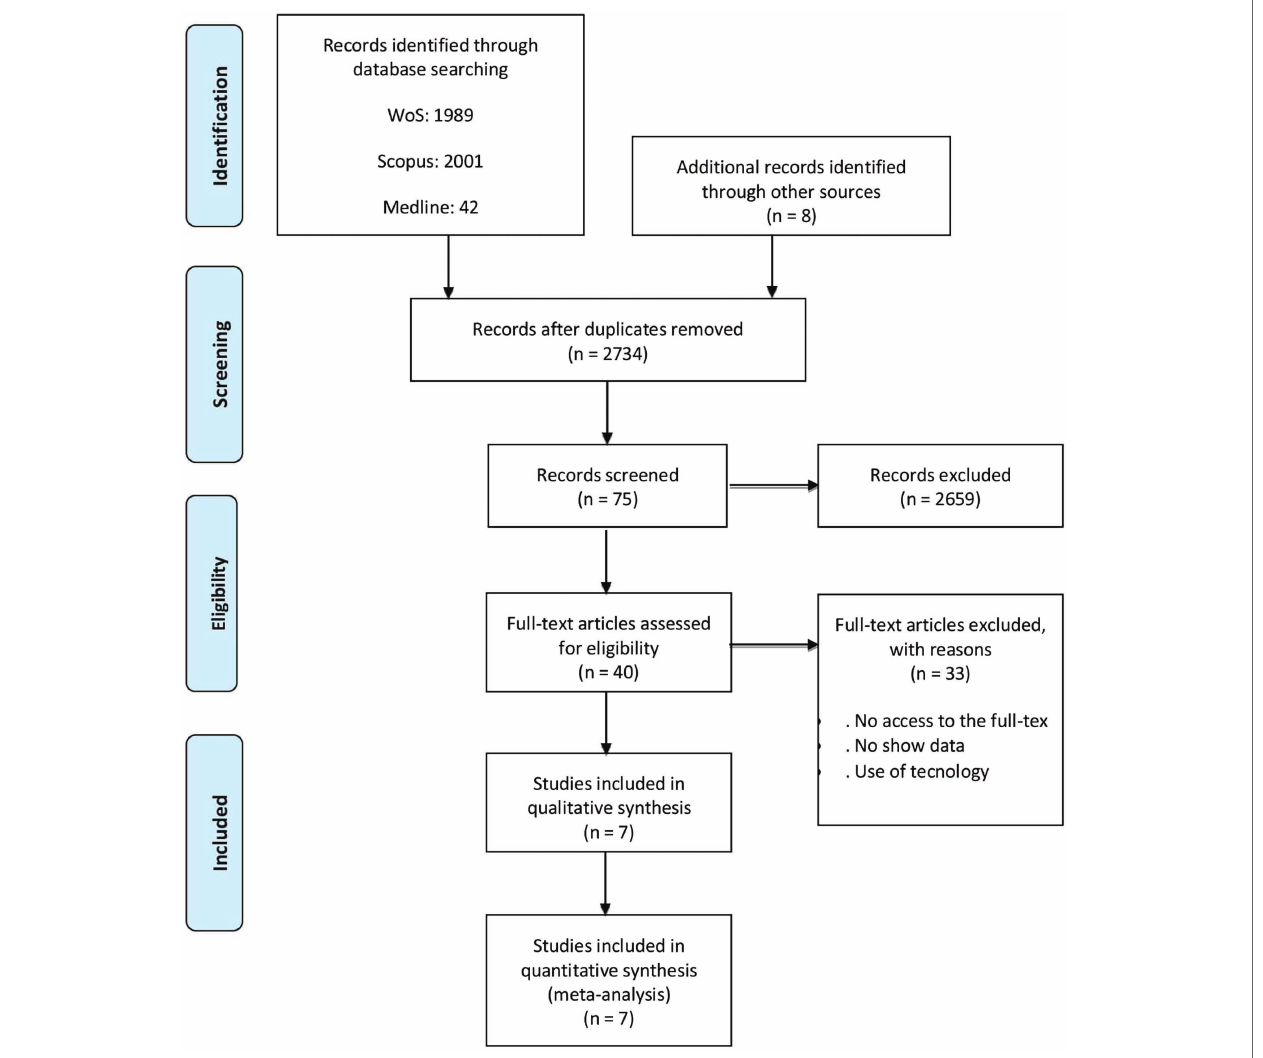
FIGURE 1 | Flow diagram for the selection of